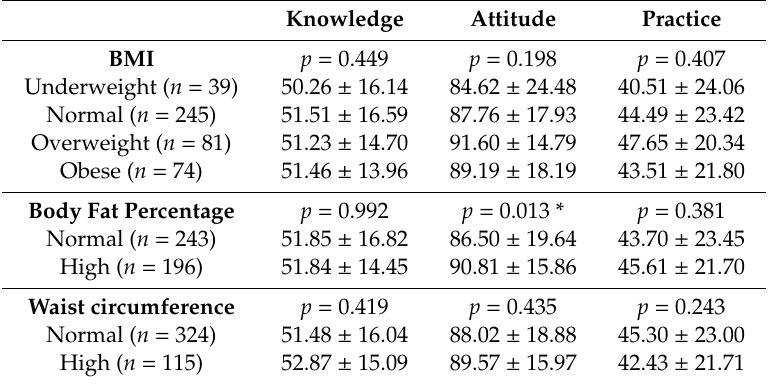
Table 7. Mean ± SD of knowledge, attitude and practices (KAP) and body